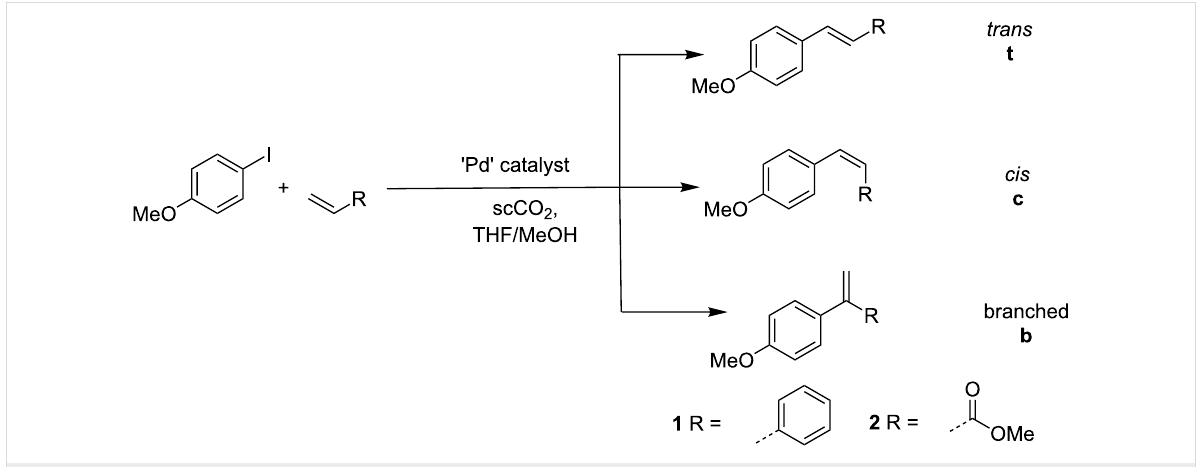
Scheme 1: General Heck reaction showing the possible isomers that can be